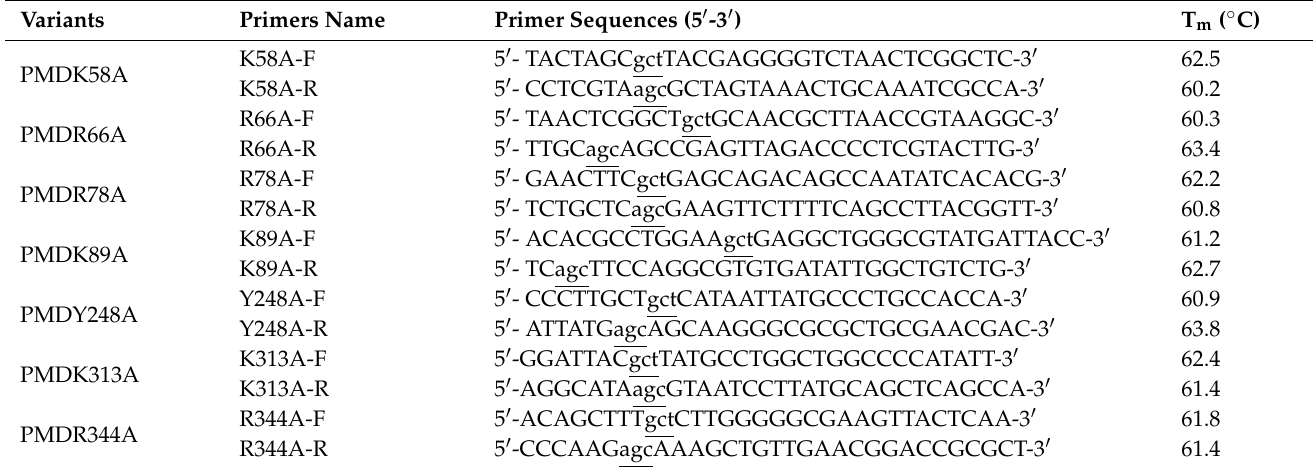
Table 2. Primer sequences used for site-directed